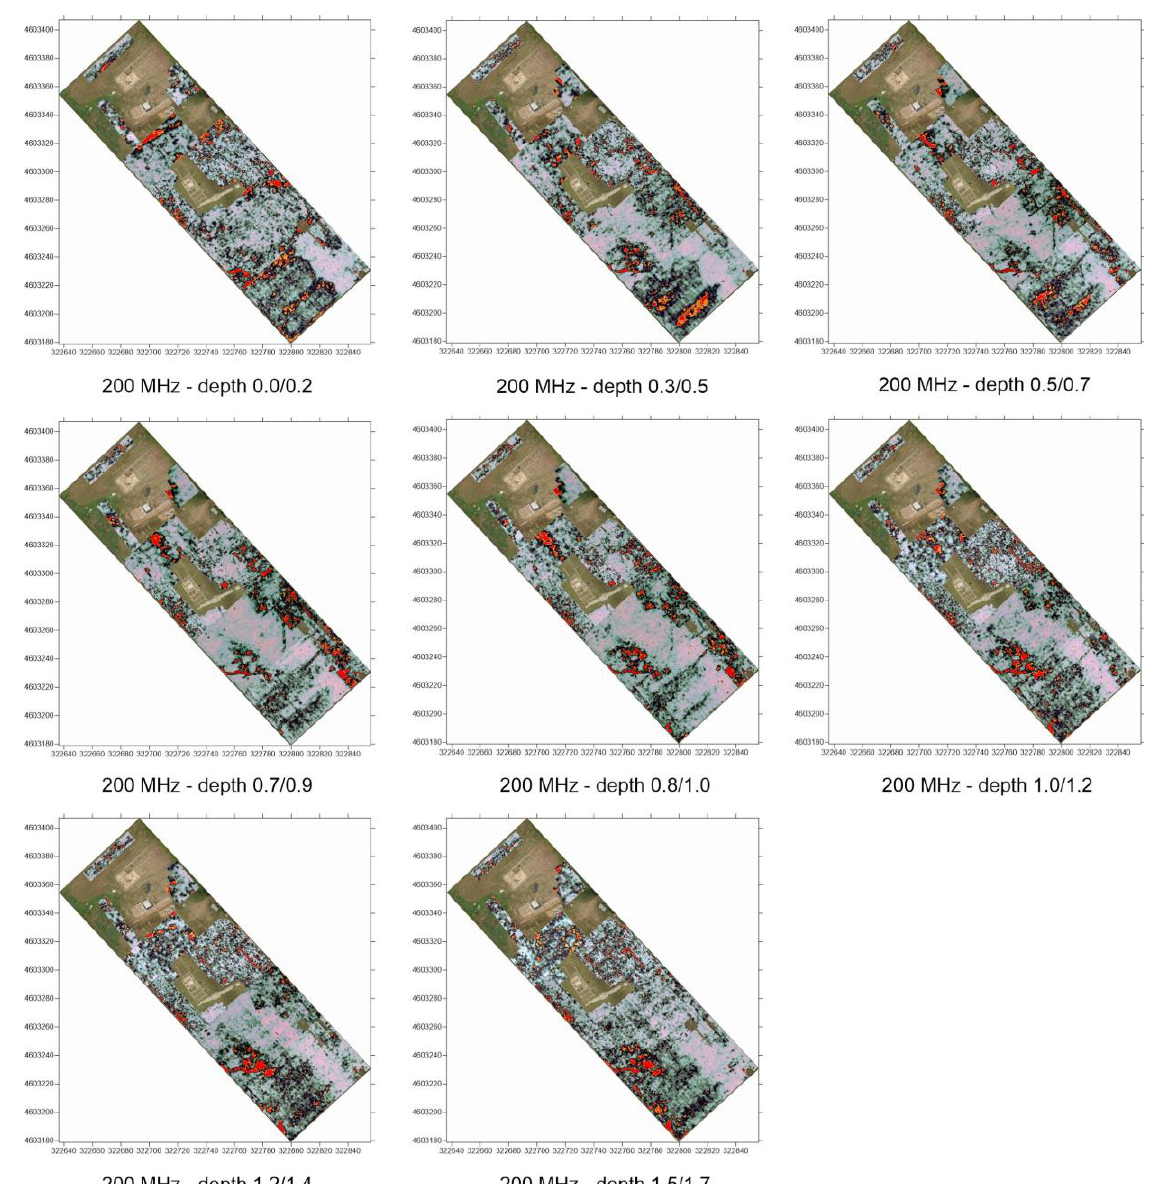
Figure 14. Selection of time slices collected with 200 MHz antenna.